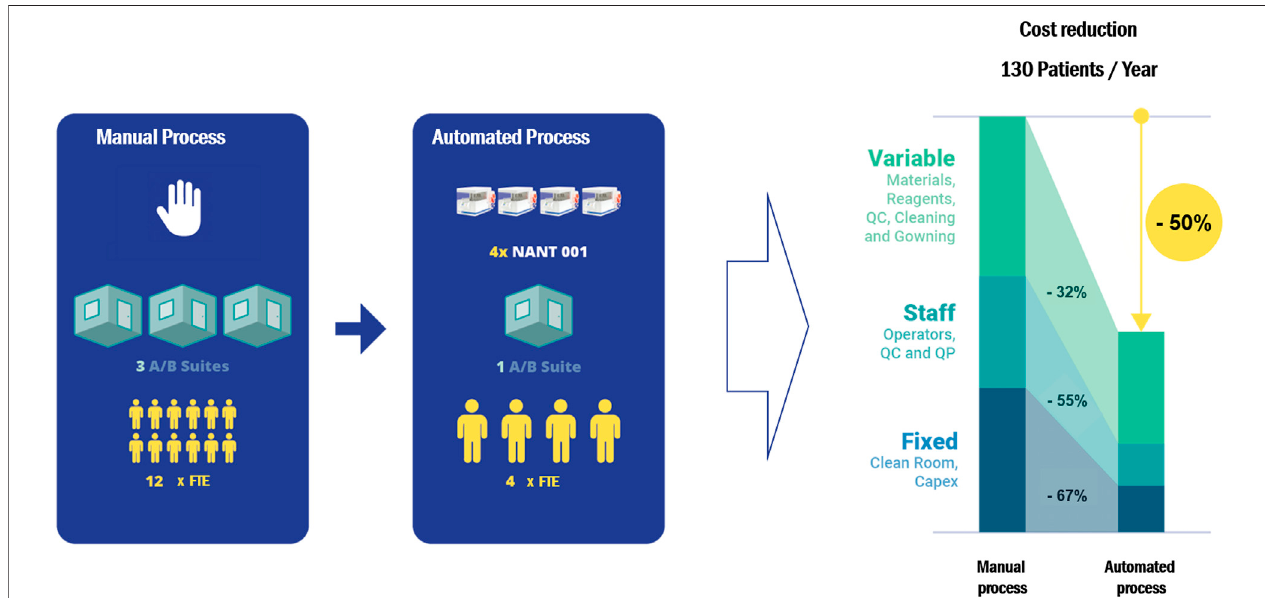
FIGURE 5 | A cost-effectiveness analysis comparing the cost of a manual expansion process with an automated process using the NANT 001 system to produce 130 batches of an autologous ASC therapy per year. The following assumptions were applied: personnel consists of a production team of two manufacturing technicians, one QC technician and one Quali fi ed Person (all FTE), one Class A/B cleanroom facility available and a production process of 7 ± 1 days. Upstream, downstream and all manual expansion processes would be performed in a Grade A/B cleanroom with the bioreactors operating in a Grade D area. All relevant manufacturing costs including direct and indirect fi xed costs and direct variable costs for the expansion phase and all upstream and downstream processes were calculated and compared.